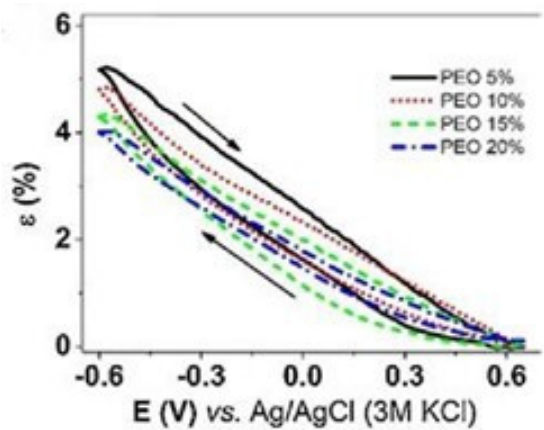
Figure 13. Strain ( ε ) profile of PPy/DBS-PEO materials in LiTFSI aqueous media with different contents of PEO and of CFS-PPyTF in CCM electrolyte [42]. Reprinted with permission from Else- vier.